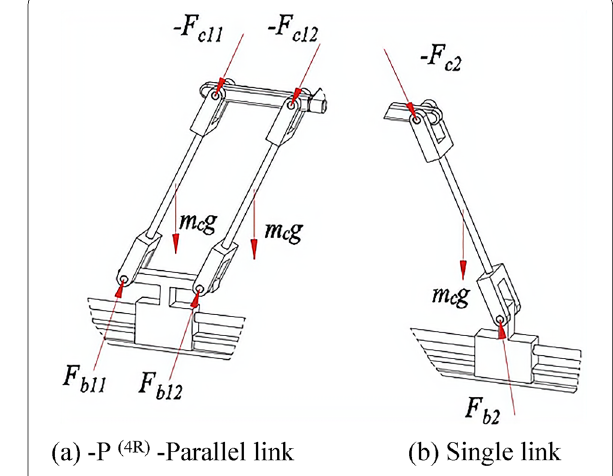
Figure 5 Force analysis of sub-moving platform Figure 6 Force analysis of